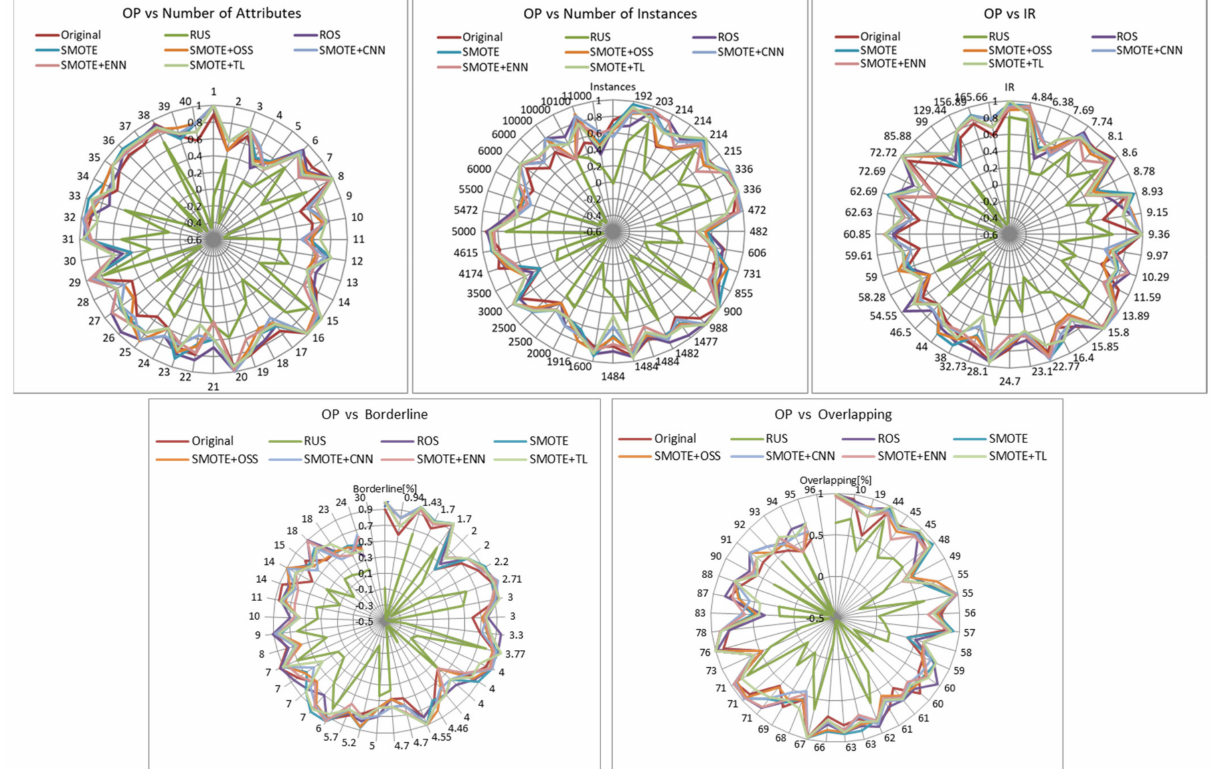
Figure 7. Influence of dataset characteristics on IBA for all resampling strategies.